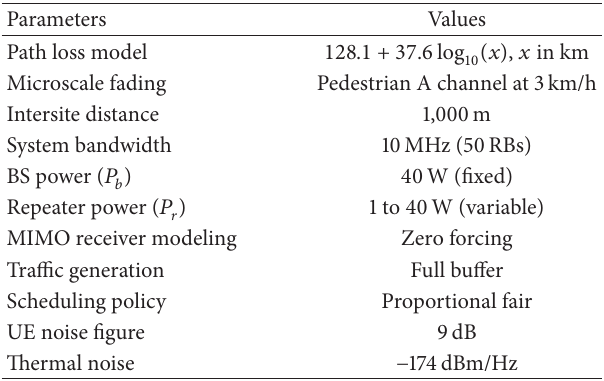
Table 2: Simulation